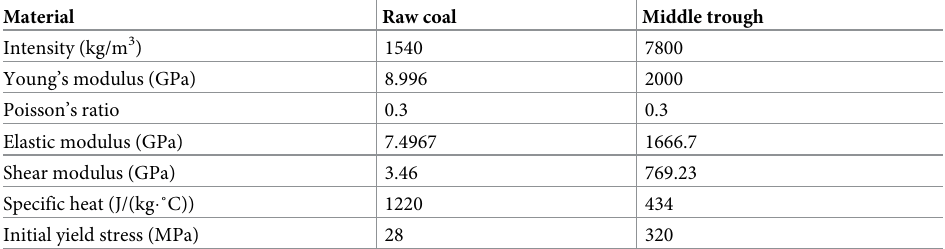
Table 4. Material properties of the middle trough and raw coal impact